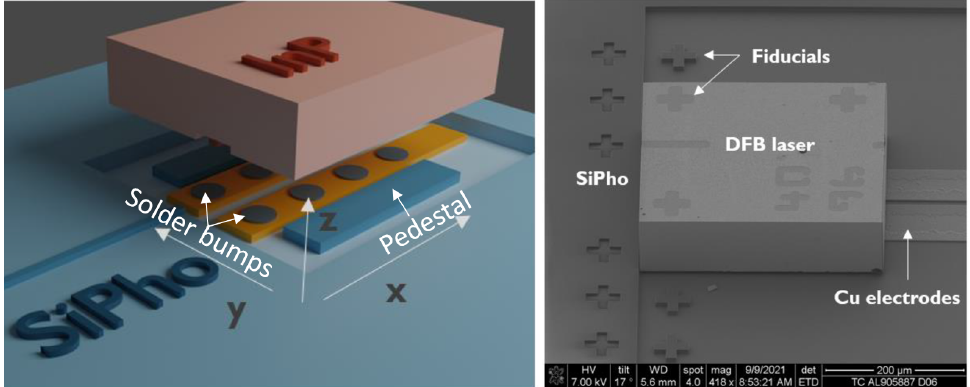
Figure 1. Hybrid integration of InP laser by flip-chip bonding on SiPho die. Pedestals are present for mechanical support. Figures were adapted from